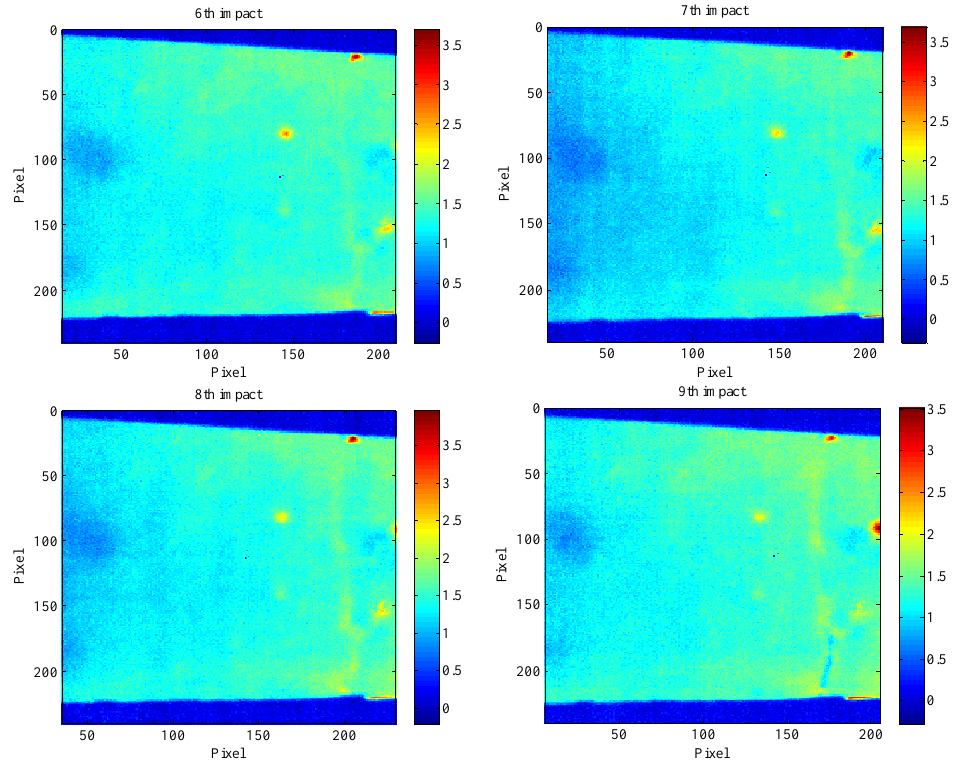
Figure 7. Thermal contrast of last four impacts in the cool ‐ down period.